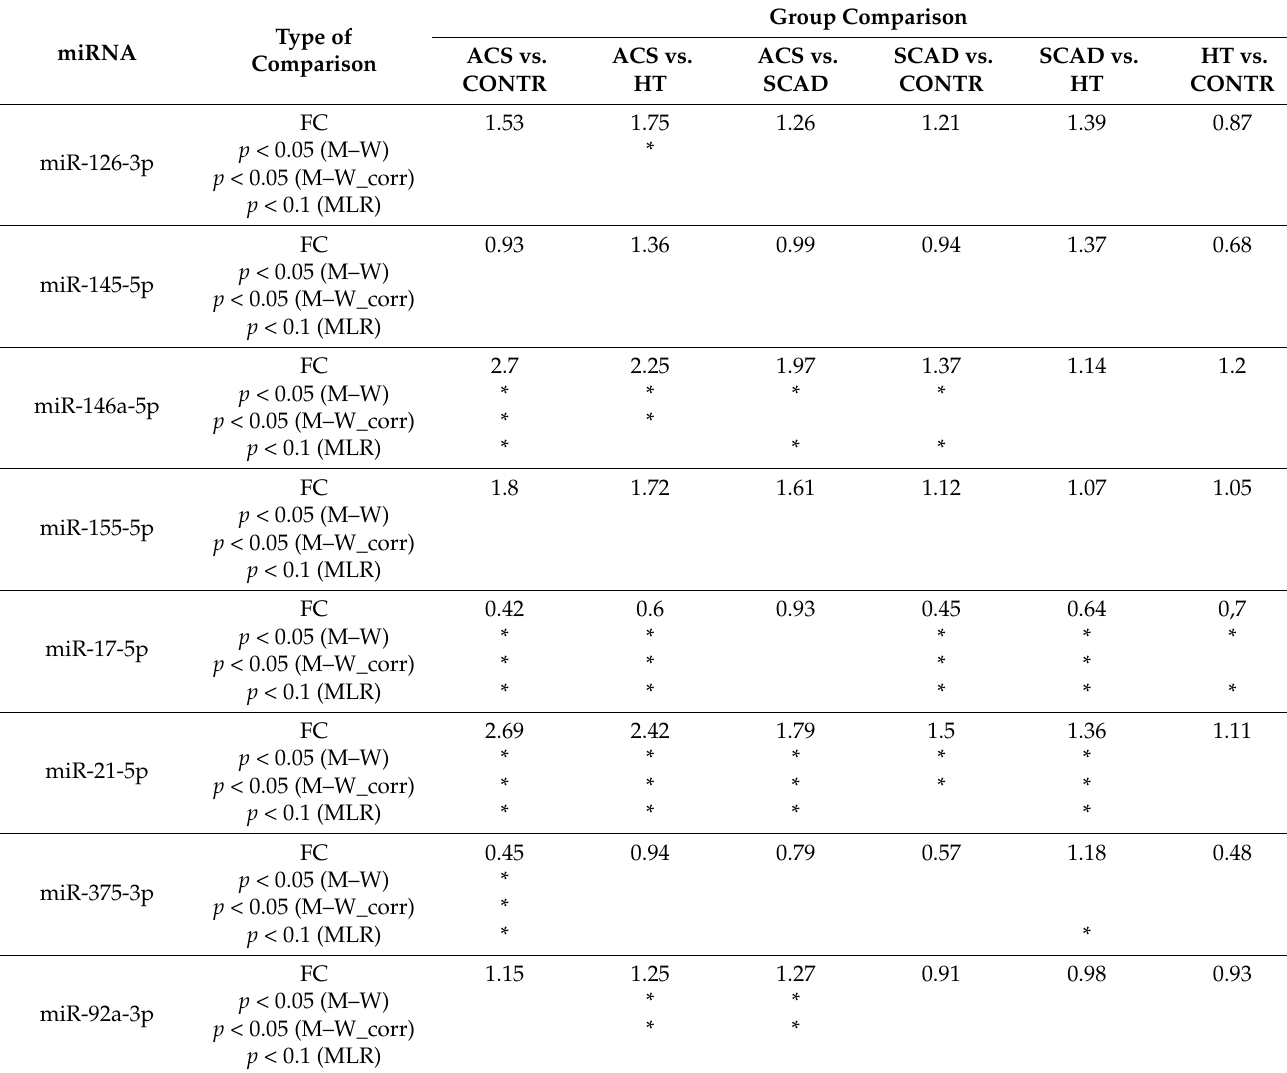
Table 3. Results of the study sample group pairwise comparisons to determine statistically significant differences in relative plasma miRNA levels. Different types of statistical analyses were used to obtain p -values of significance: Mann–Whitney test (M–W); Mann–Whitney test with the Bonferroni–Holm correction for multiple comparisons (M–W_corr); multiple linear regression analysis (MLR) with the Bonferroni–Holm correction for multiple comparisons, in which relative plasma levels of eight candidate miRNAs were included in the MRL model with HS, dCq(miR-23a-3p–miR-451a) and type 2 diabetes presence as confounding factors. Asterisks * indicate the presence of statistically significant changes between the compared groups. FC, fold-change values of miRNA mean relative plasma levels for pairwise comparisons; ACS, 50 ACS patients; SCAD, 26 patients with stable CAD; HT, 30 hypertensive patients without CAD; CONTR, 30 healthy